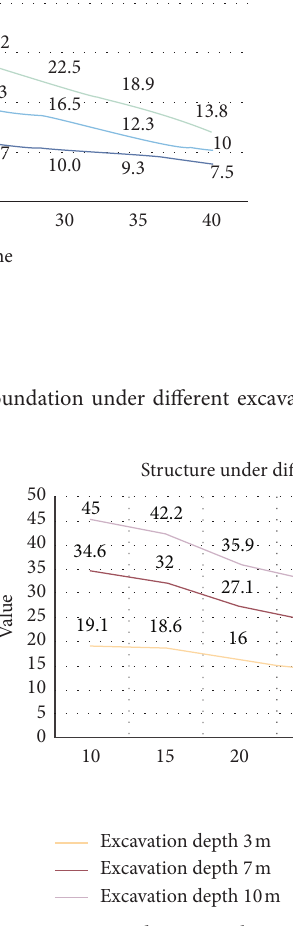
Figure 4: Foundation settlement diagram of the frame shear structure under different excavation